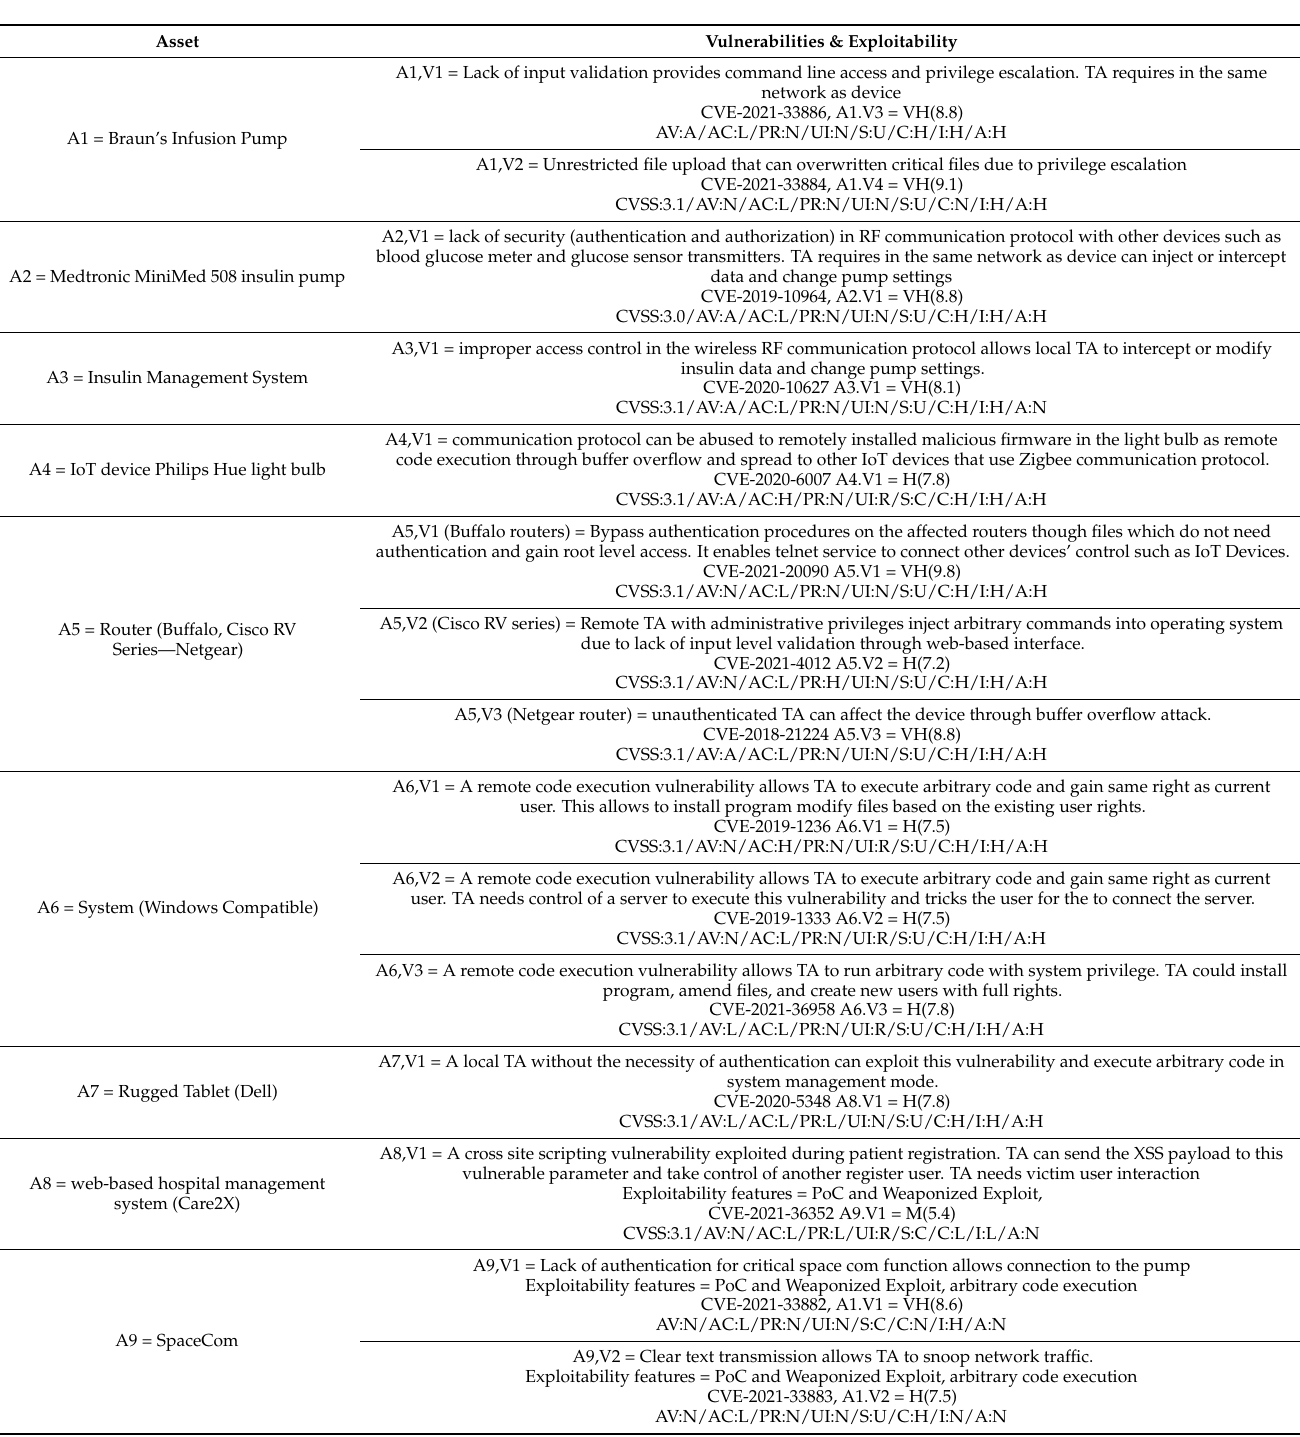
Table 5. Vulnerabilities and CVSS metrics for each